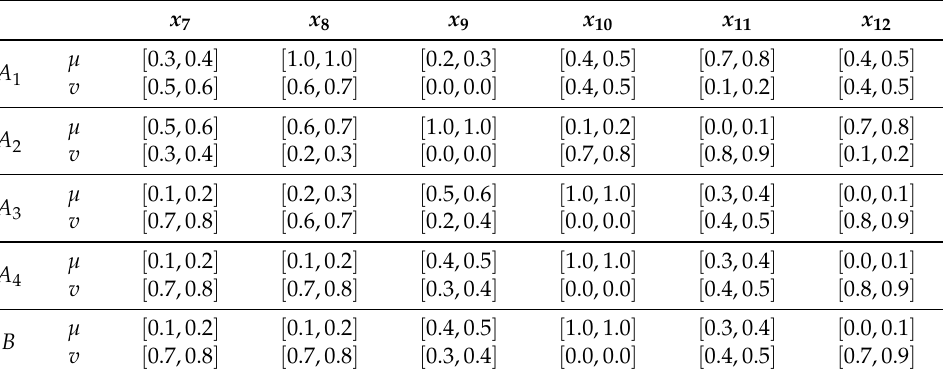
Table 2. The four classes of building materials A i , i = 1,2,3,4 [15].